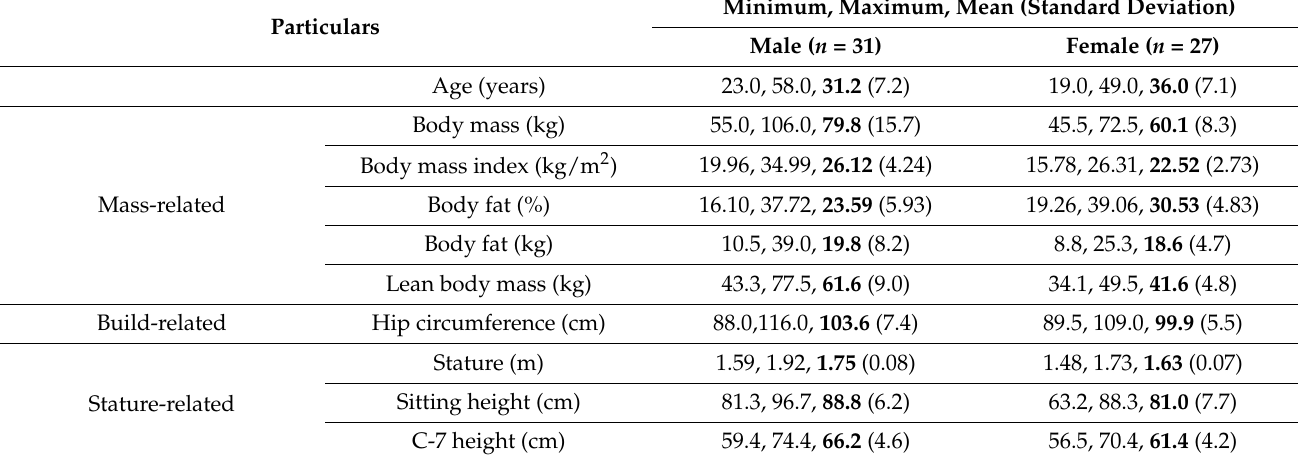
Table 1. Mean, standard deviation, minimum, and maximum values of the selected anthropometric